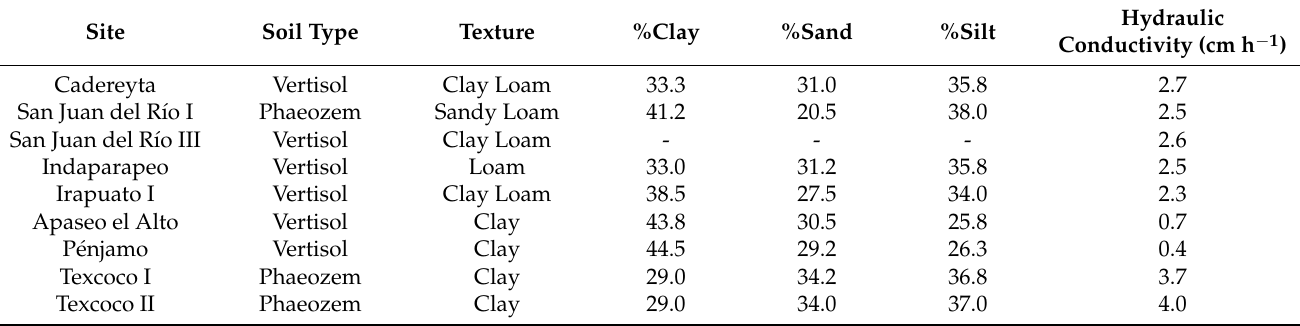
Table 2. Soil type, texture and hydraulic conductivity at the